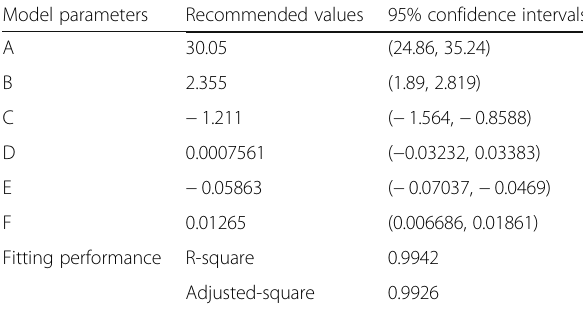
Table 2 Coefficient of the recommended values and 95% confidence intervals Model